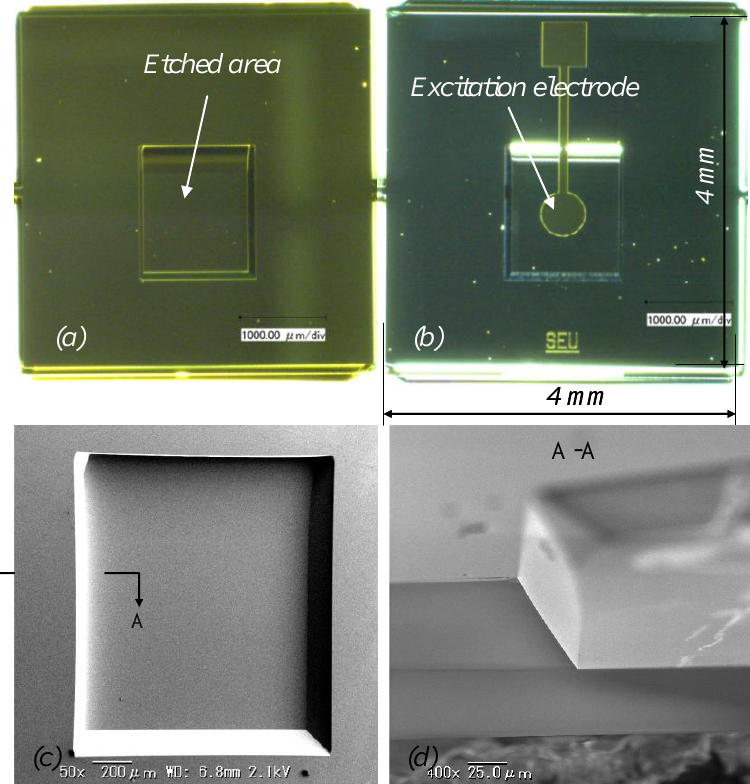
Figure 5. Representative images of a fabricated QCM chip: ( a ) top view; ( b ) back view; ( c ) close-up SEM image of the etched area; and ( d ) cross section of the etched area.